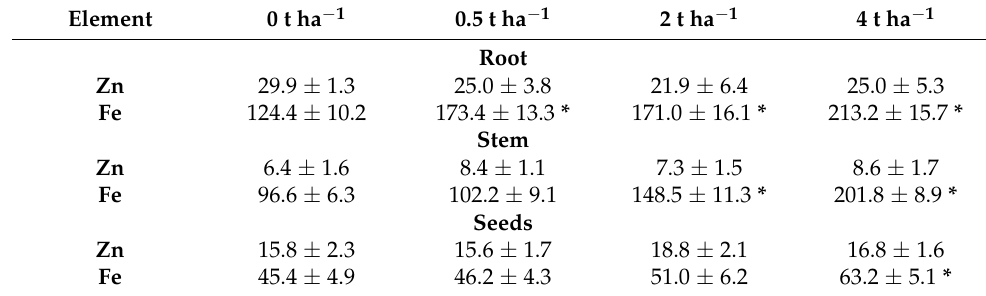
Table 1. The content of metals in the tissues of spring rapeseed, mg kg − 1 . Element